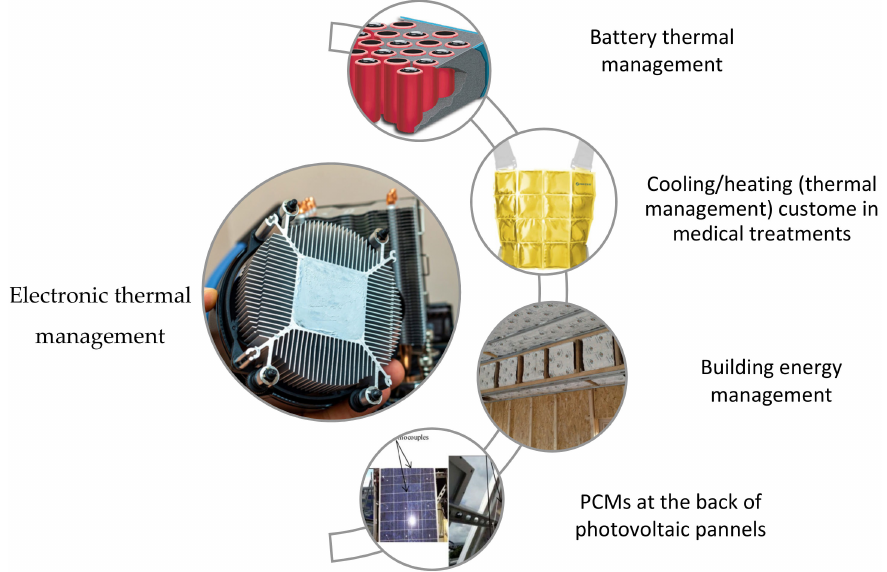
Figure 2. A schematic showing various PCM